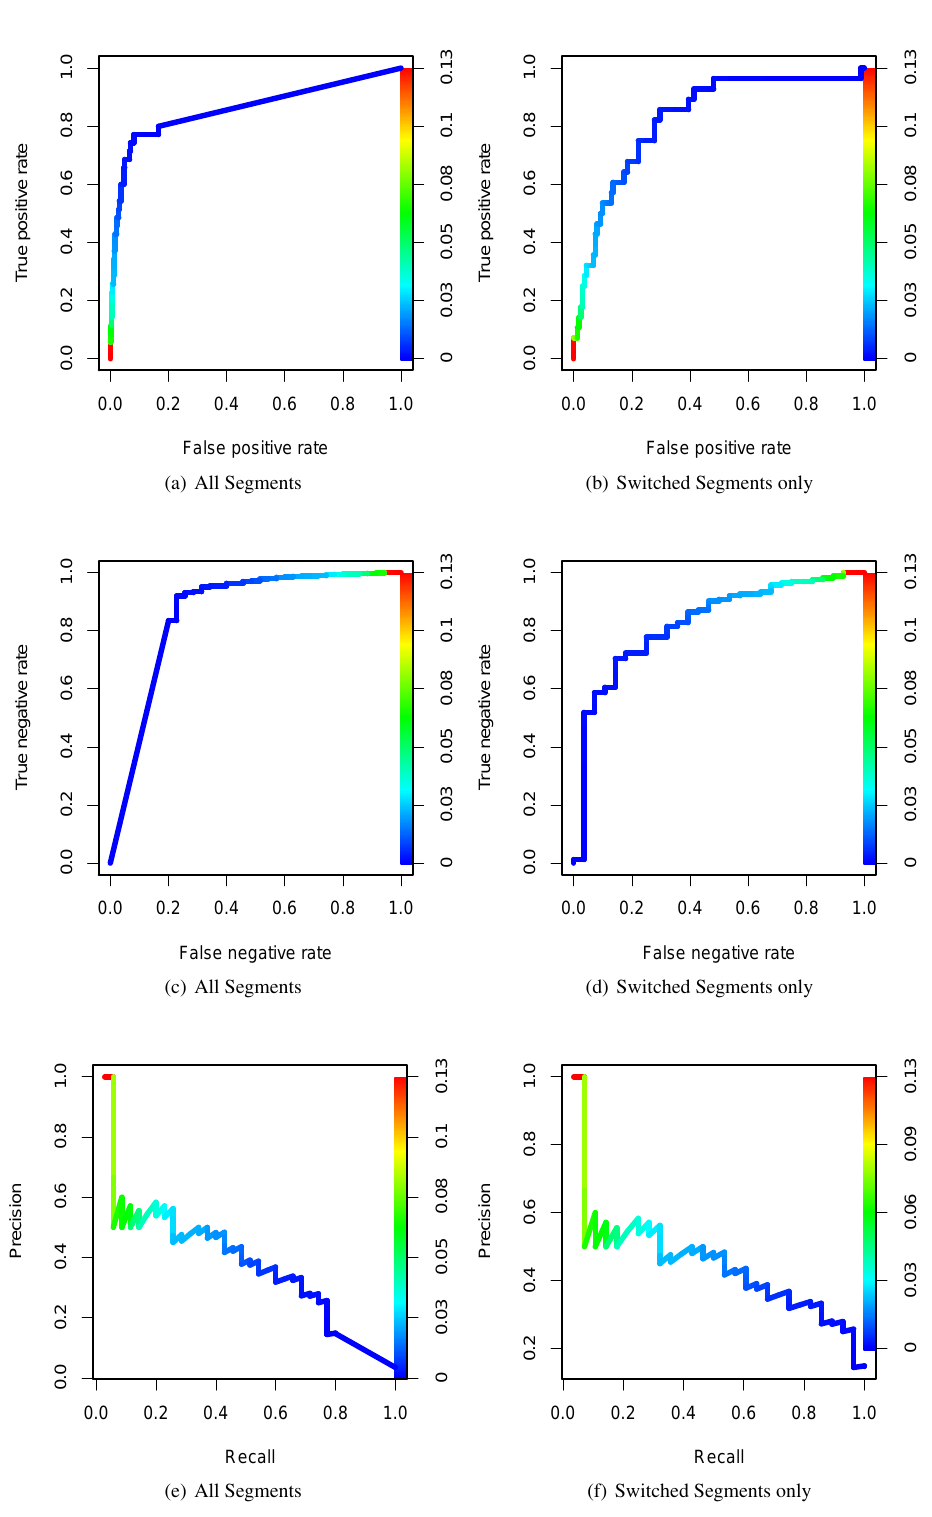
Figure 4: Evaluation results true/false positives/negatives and precision/recall with update segment significance as threshold, not de- tected changes are given a rating of -0.0001 for visualization